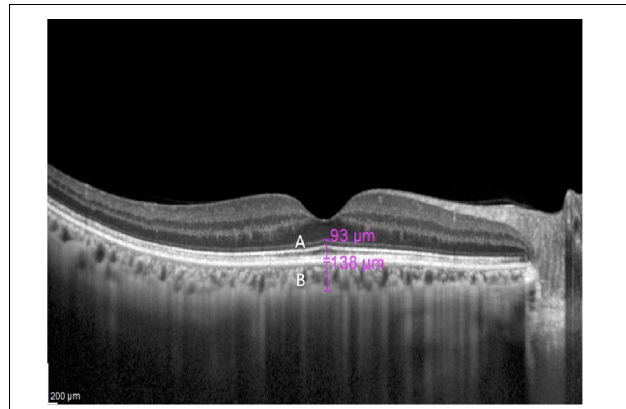
FIGURE 1 | A macula optical coherence tomography (OCT) section of a 67-year-old with myopia of –6.5 D. The magenta lines indicate foveal photoreceptor thickness (FPT) (A) and subfoveal choroidal thickness (SFCT) (B) .